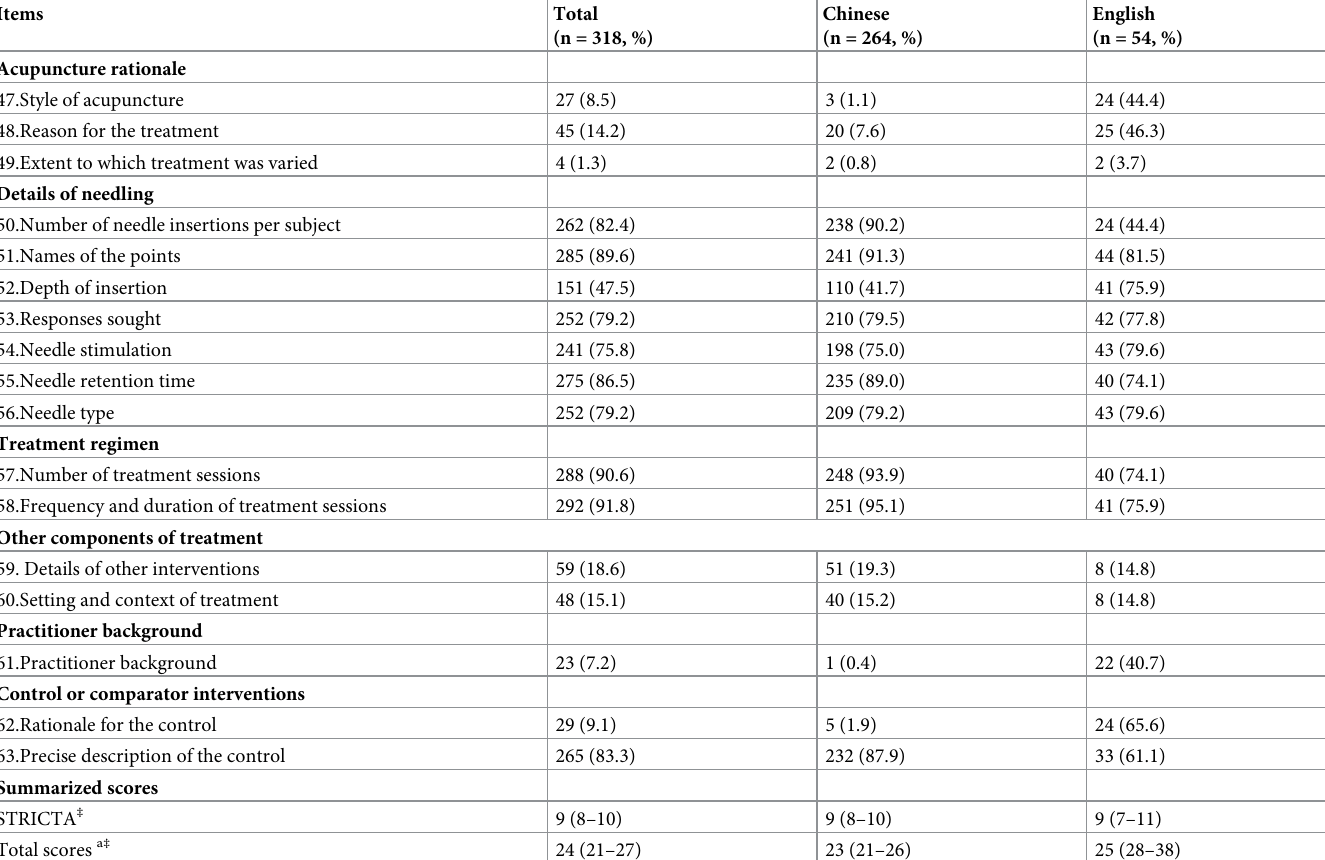
Table 3. Compliance of reporting to the STRICTA